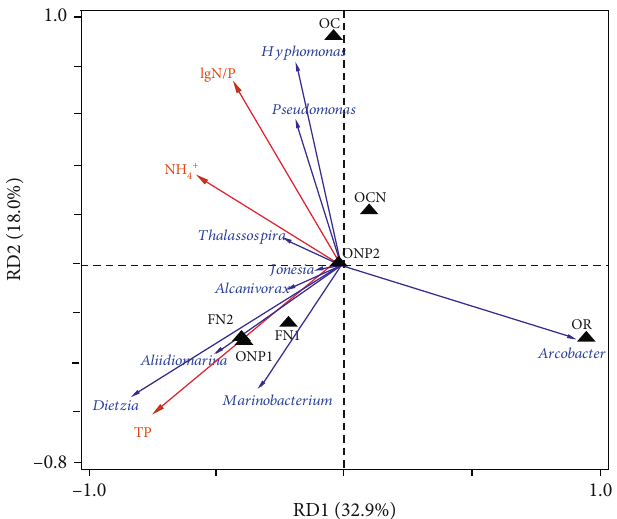
Figure 7: Redundancy analysis (RDA) of each sample; the right arrows indicated the contribution of each environmental factors; the dark blue arrows indicated genera of abundant relative abundance; the solid square indicated the seven